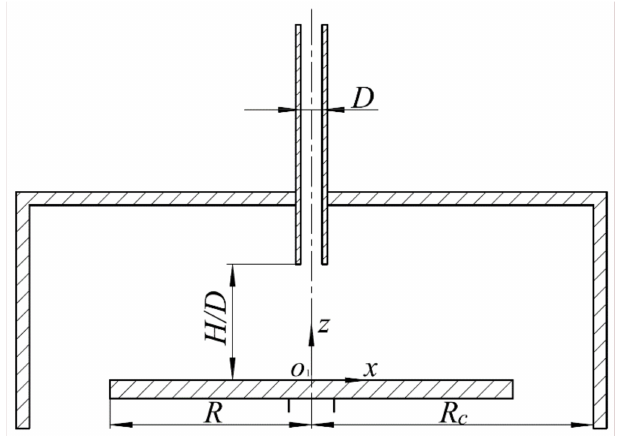
Figure 1. Schematic diagram of jet impacting a stationary